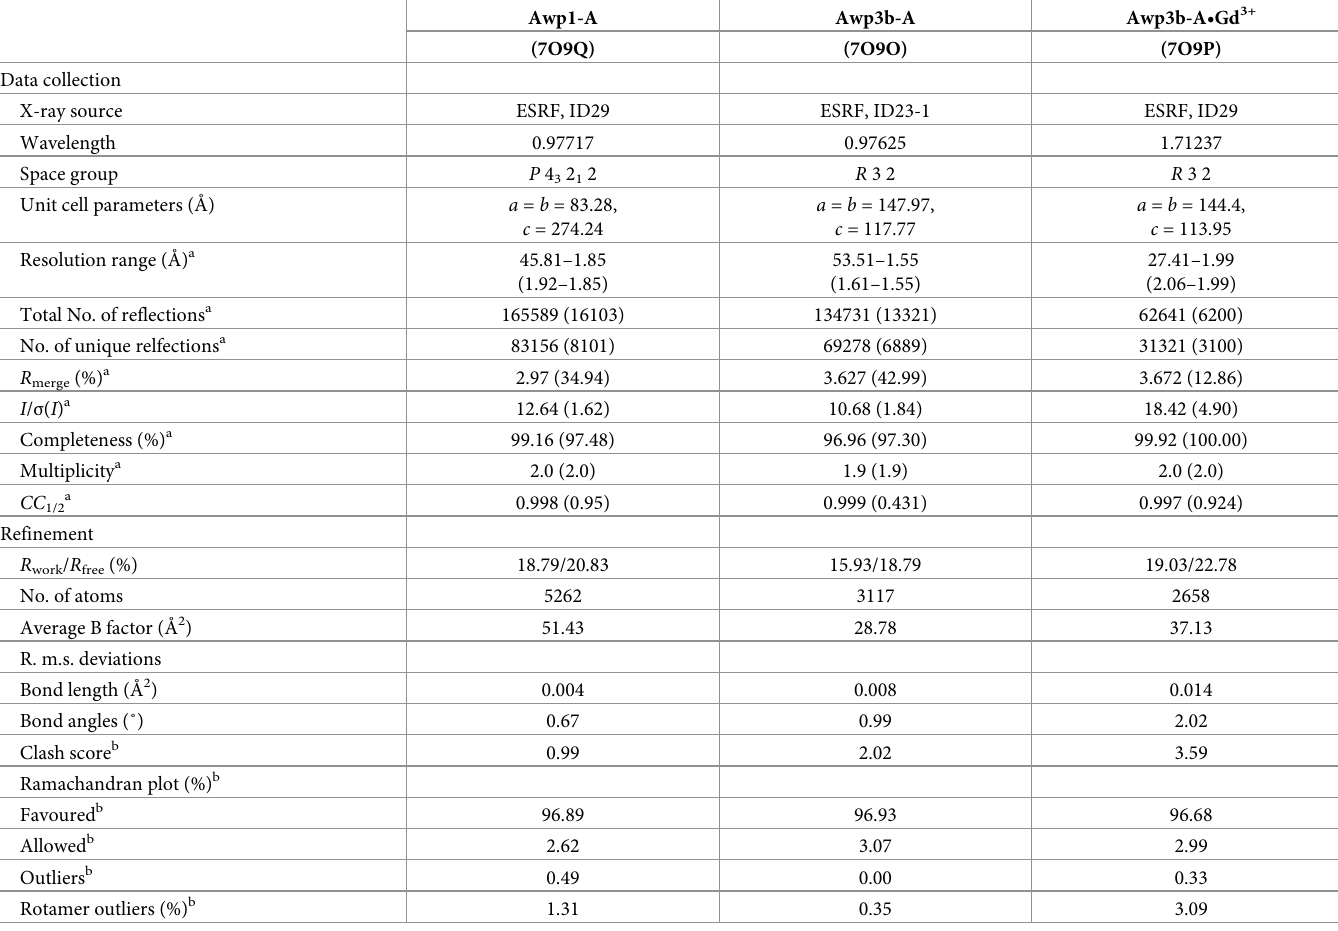
Table 2. Data collection and refinement statistics for crystal structures of Awp1- and Awp3b-A regions. Deposition numbers for the RCSB protein data bank are given in parentheses. Data collection statistics is generated by SCALA